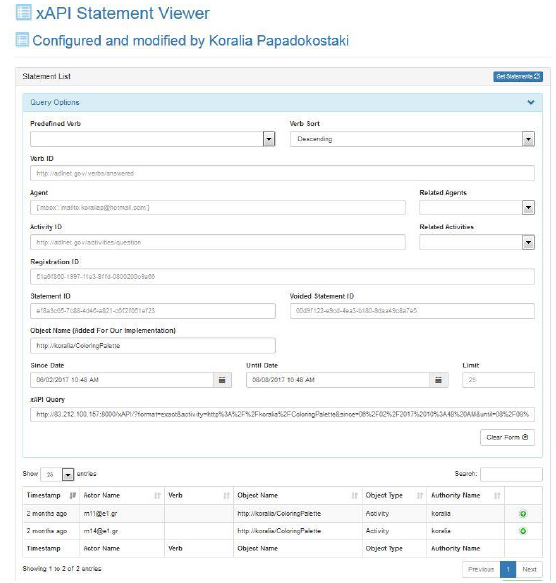
Figure 23. The querying form showing which students actually clicked on the